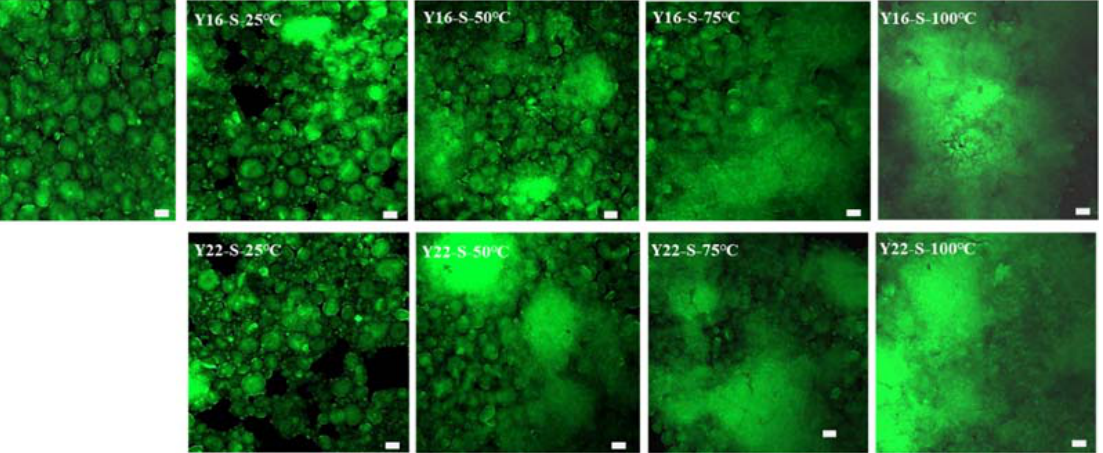
Figure 2. The CLSM of native starch and different gluten–starch mixtures during heating. Size bar = 50 μ m.